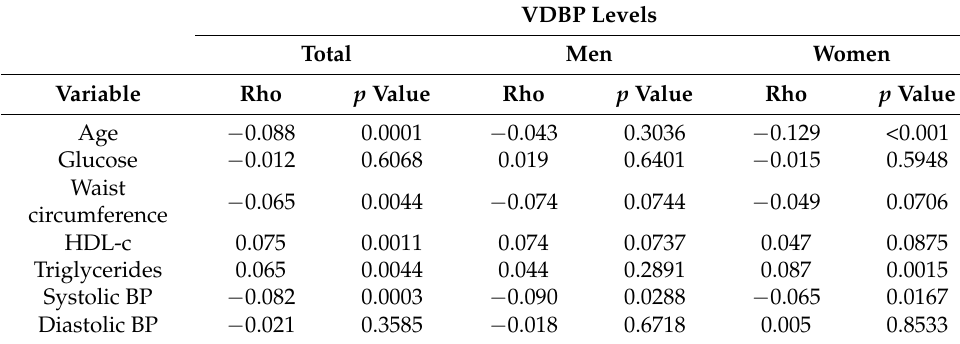
Table 4. Spearman correlations between VDBP and MetS